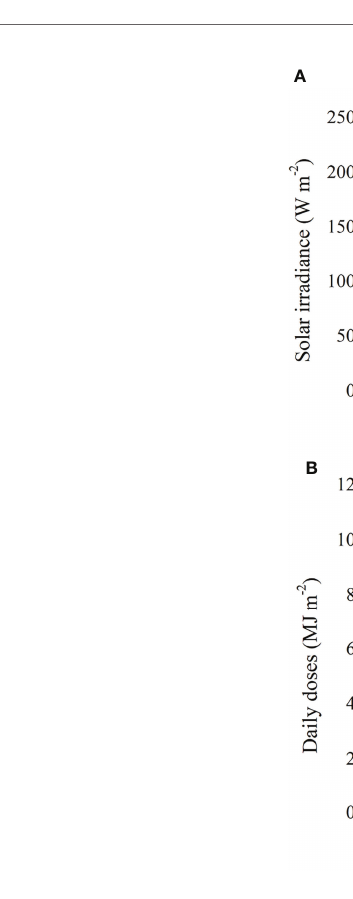
FIGURE 2 | Average irradiance levels (A) and daily doses of (B) of PAR, UVA, and UVB during the experiment period. PAR, photosynthetically active radiation; UVA, ultraviolet A; UVB, ultraviolet